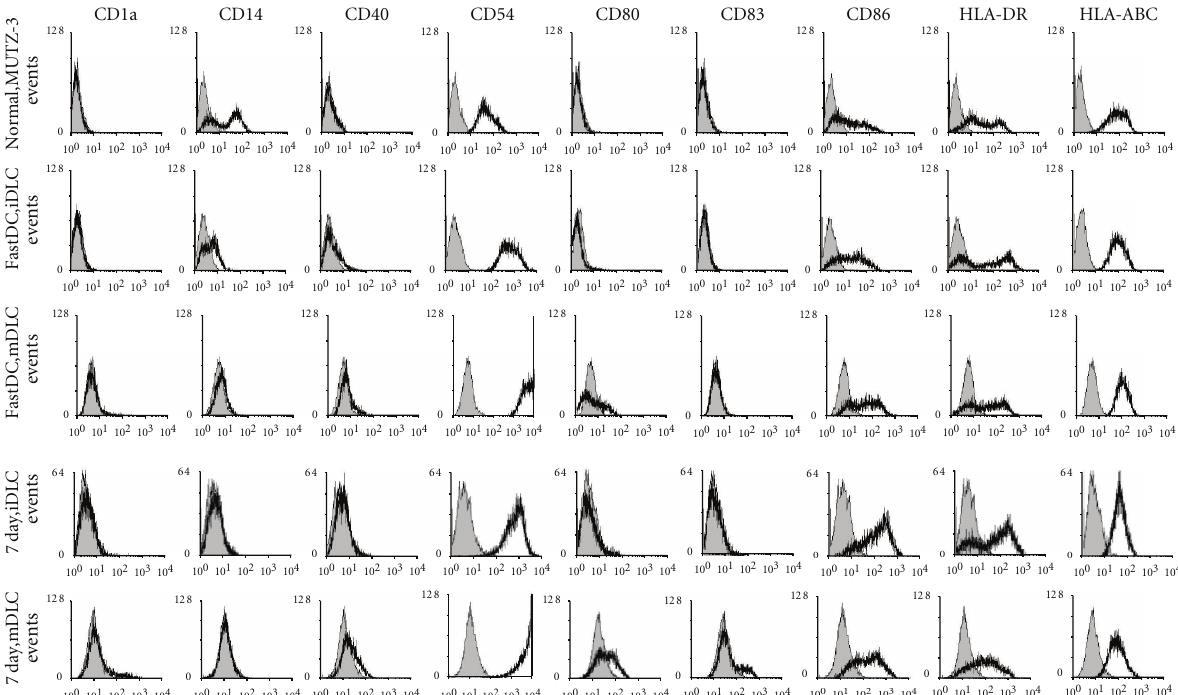
Figure 2: DLC phenotypes of MUTZ-3. DLC generated from MUTZ-3 after culture using FastDC and 7-day culture methods. One representative result from three experiments is shown. Isotype controls are shaded and surface markers are unshaded in